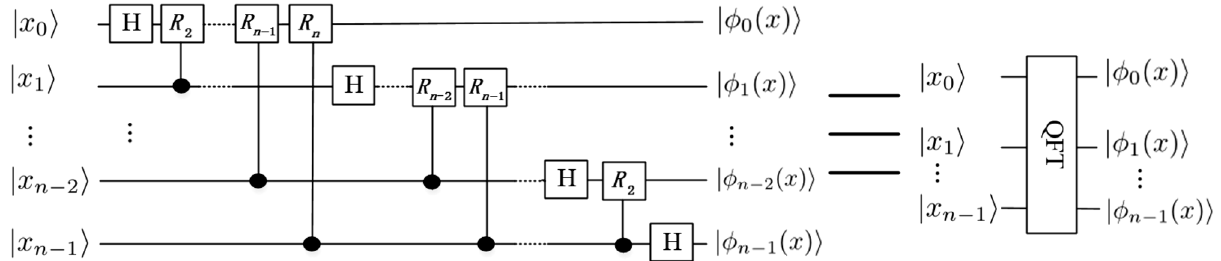
Figure 4. Quantum circuits that implement QFT. Not shown are swap gates at the end of the circuit which reverse the order of the qubits 31